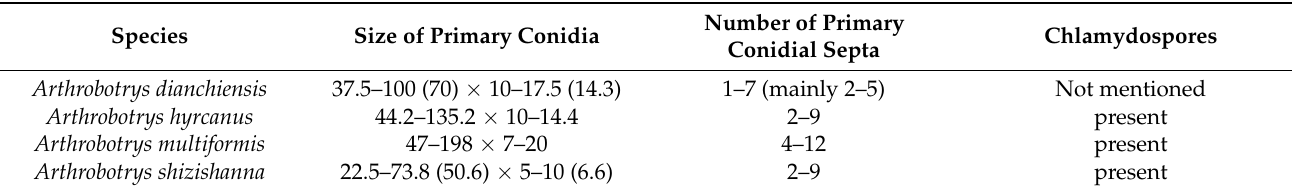
Table 3. Diagnostic characters of Arthrobotrys hyrcanus , sp. nov., and closely related species. Reference: Yu et al. [28] and this